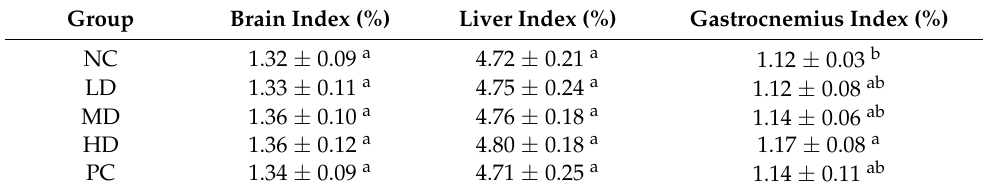
Table 3. Effect of HGP on organ index of experimental mice. Group